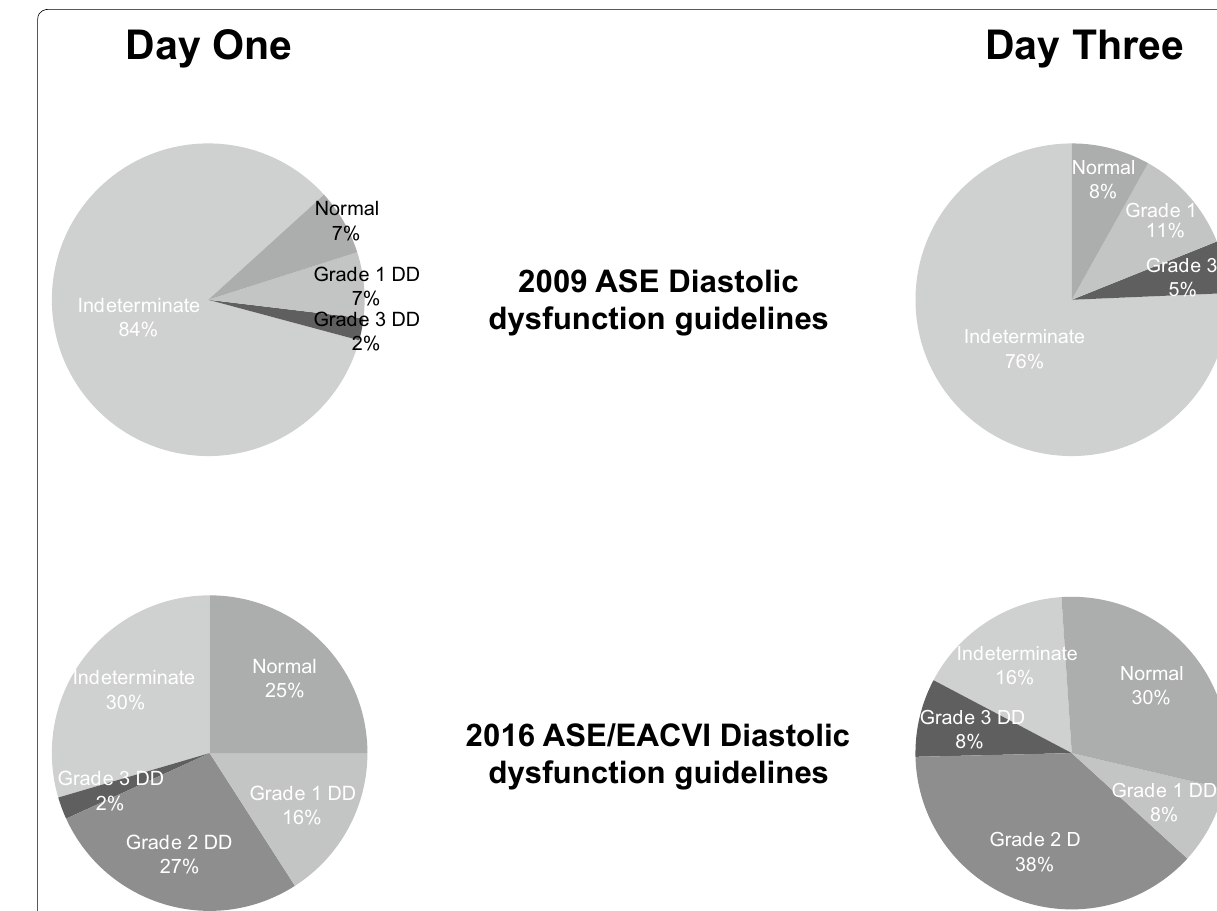
Fig. 4 Grading of diastolic dysfunction according to 2009 ASE and 2016 ASE/EACVI algorithms for diagnosis of diastolic function in patients with normal systolic function on days 1 and